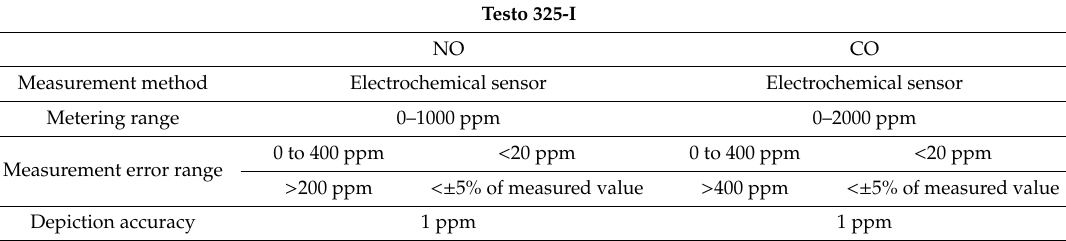
Table A3. Measurement method and measurement error range stated by Testo 325-I analyzer manufacturer